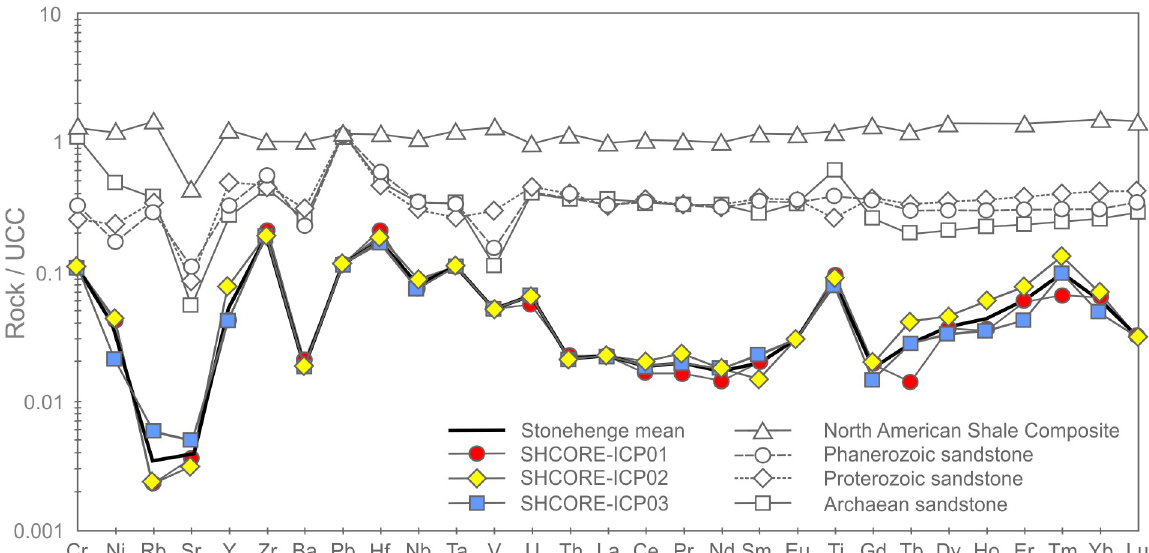
Fig 20. UCC-normalised trace element diagram for the three subsamples from section 2–3 of the Phillips’ Core from Stonehenge showing North American Shale Composite [45] and average compositions of Archean, Proterozoic and Phanerozoic sandstones (SST) [44] for comparison [normalising factors from